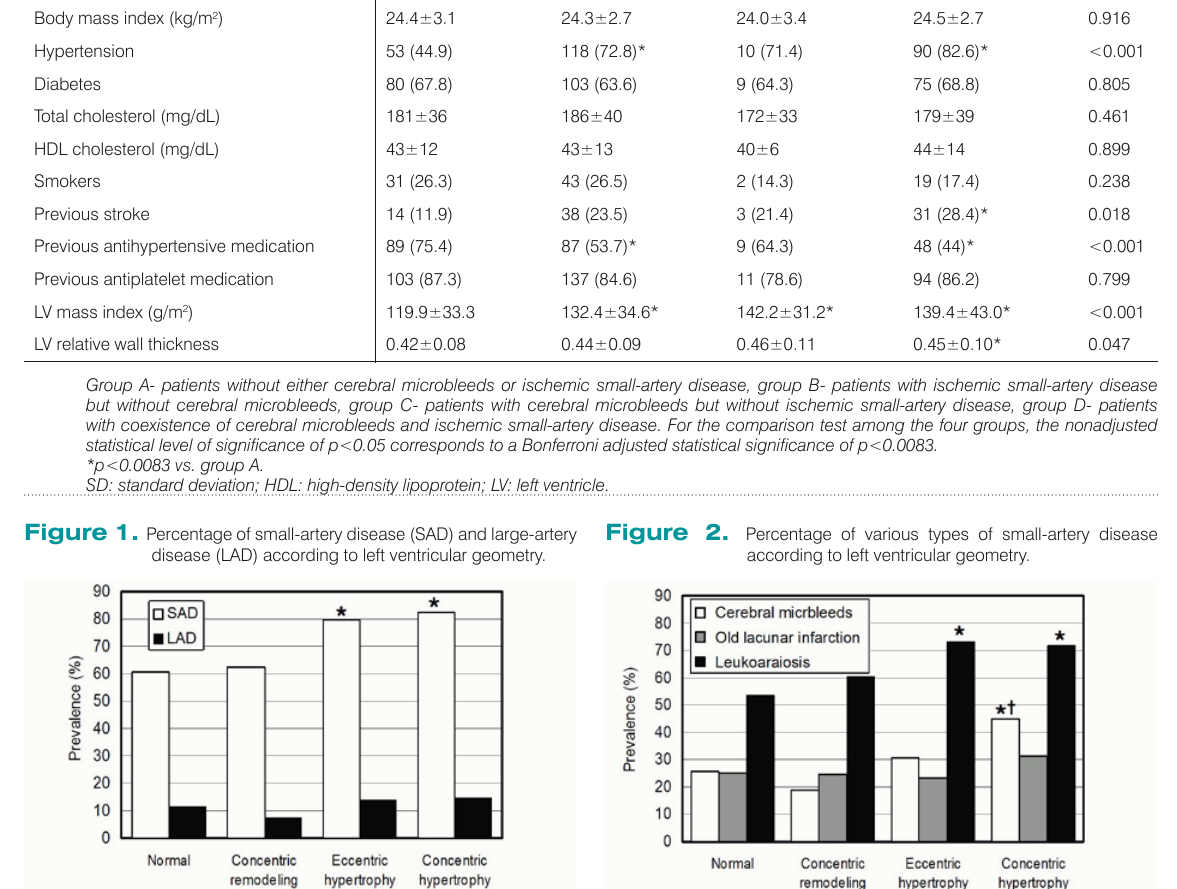
For the comparison test among the four groups of left ventricular geometry, the nonadjusted statistical level of significance of p<0.05 corresponds to